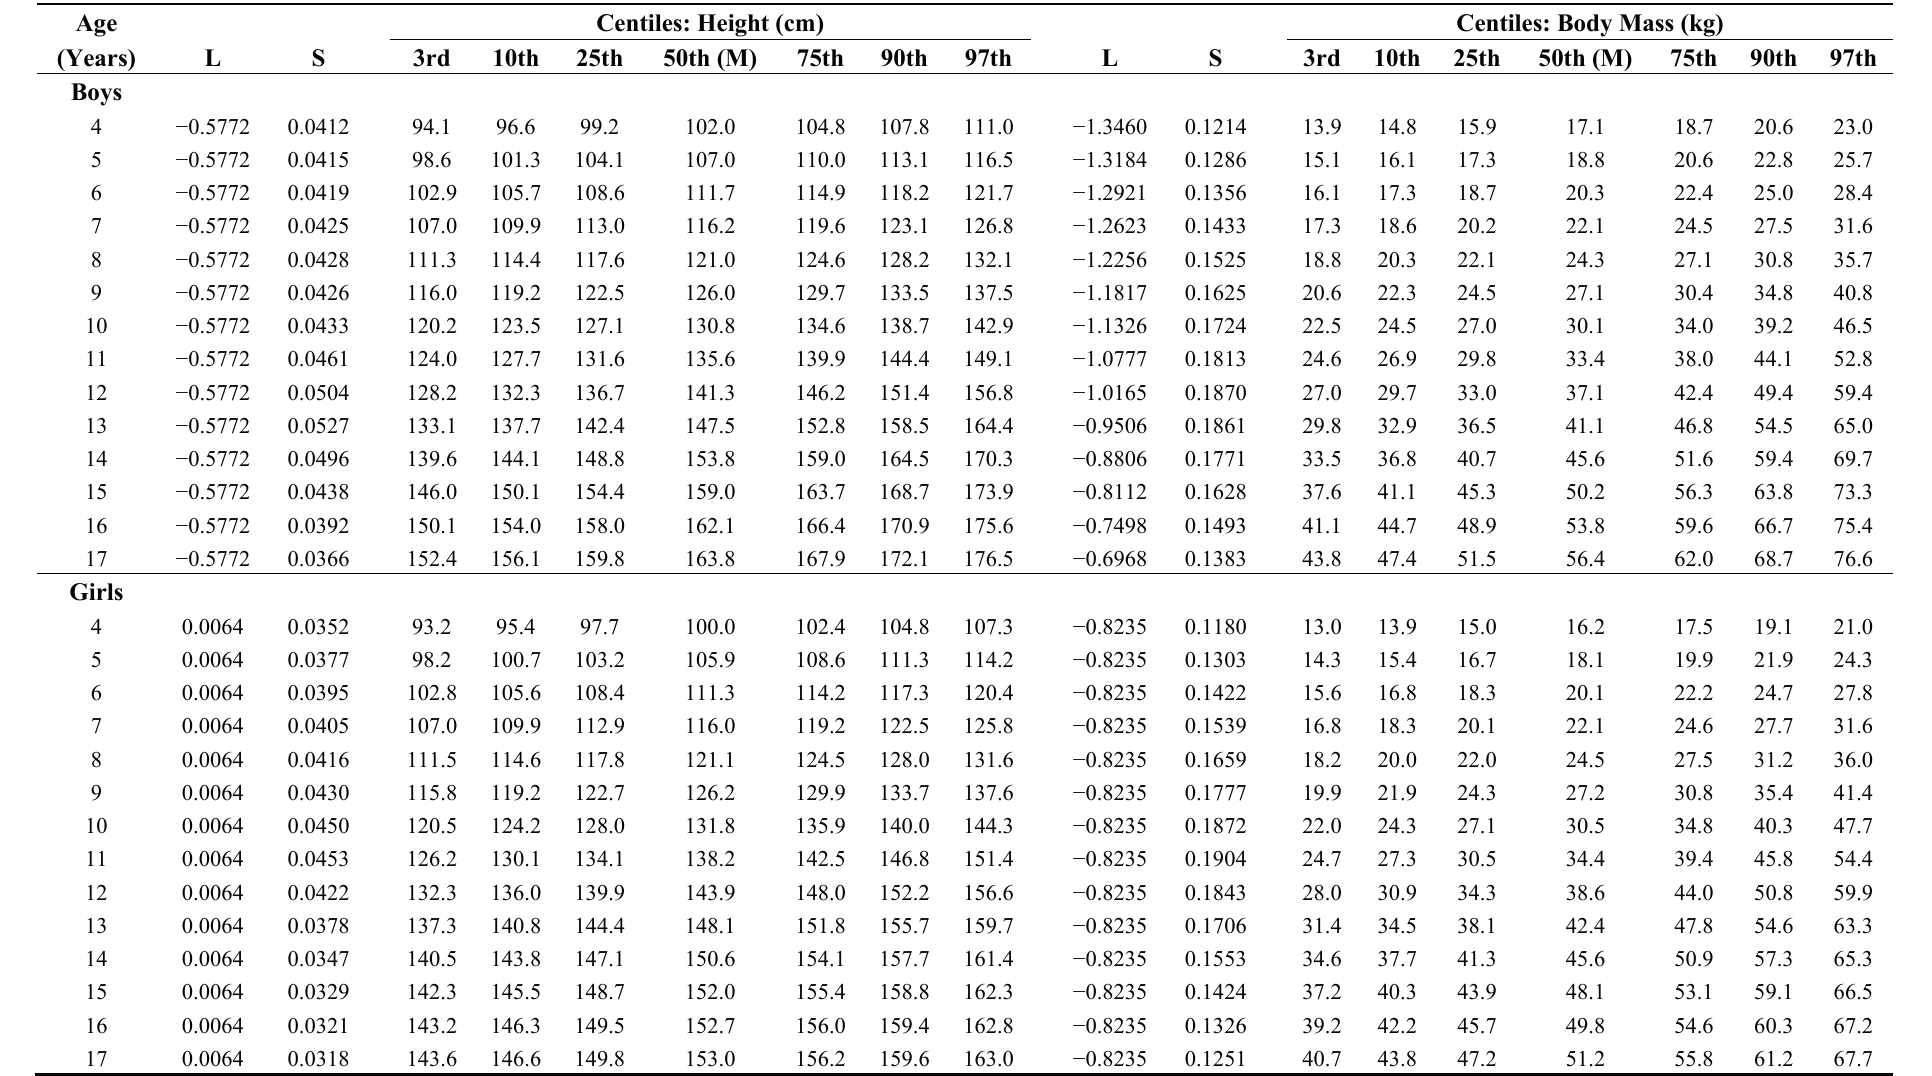
Table 4. Age- and sex-specific percentiles of height (cm) and body mass (kg) for school-aged Peruvian children and adolescents. Age Centiles: Height (cm) Centiles: Body Mass